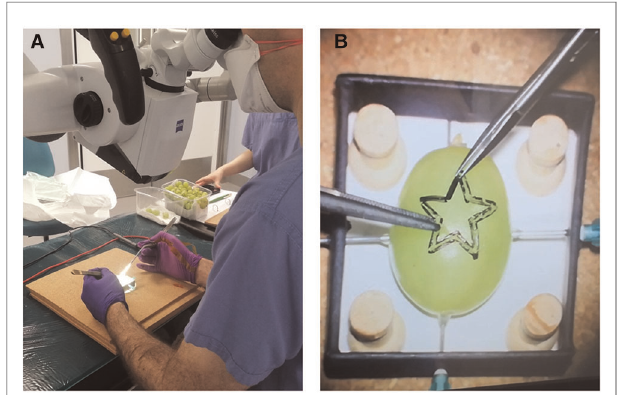
FIGURE 1 | Microsurgical grape dissection task “ Star ’ s the limit ” setup. ( A ) Microscope trial. ( B ) “ Star ’ s the limit. ” Note the grape has a homogeneous shape, drawn on by stencil, and secured using needles to ensure constant position across the